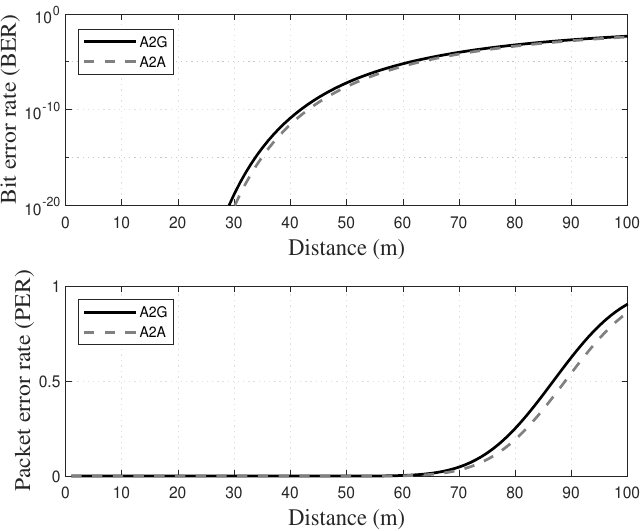
Figure 8. Bit error rate (BER) and PER based on the unmanned aerial vehicle (UAV) channel